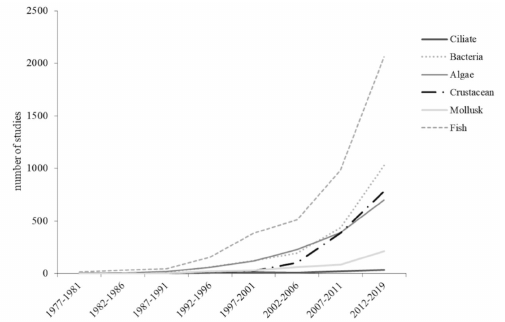
Figure 1. Number of ecotoxicological studies per model organism. Data available in the Scopus database from 1977 to 2019 (survey conducted 06/06/2019). Codes used to search: Ecotoxicol * AND ciliate *, Ecotoxicol * AND algae *, Ecotoxicol * AND bacteria *, Ecotoxicol * AND mollusk *, Ecotoxicol * AND crustacean * AND Ecotoxicol * AND fish